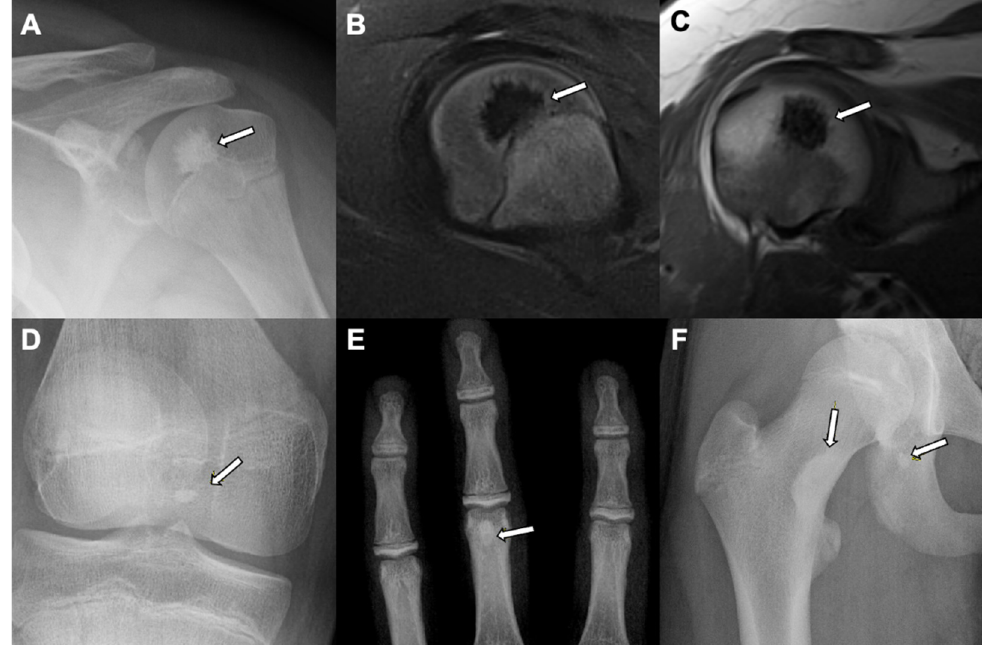
Figure 2. Bone island: A left shoulder X-ray in a skeletally immature young patient with skeletally immature bones show: ( A ) homogeneous intramedullary sclerotic focus with spiculated margin in the humeral head (white arrow). An MRI of the left shoulder of the same patient showed diffuse T1 and T2 hypointensity with spiculated margin of the lesion (white arrows) seen on sagittal T2 fat saturated sequence ( B ), and coronal proton density sequence ( C ) suggests a benign sclerotic lesion-bone island. Further examples of bone islands are seen as homogeneous intramedullary sclerotic focus (white arrows) in the tibial epiphysis in the intercondylar region of the right knee X-ray (anteroposterior view) ( D ), at the distal end of the proximal phalanx of the middle finger of the left hand X-ray (anteroposterior view) ( E ), and in the right medial femoral neck and right ischium of the right hip X-ray (anteroposterior view) ( F ) in young patients with skeletally immature bones. Osteopoikilosis (osteopathia disseminata), a heritable disorder, is characterized by